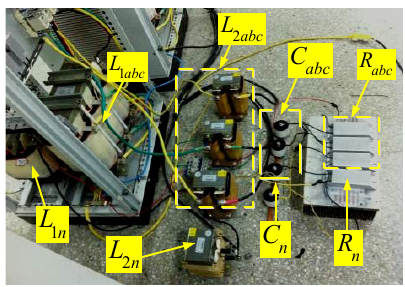
Figure 13. Implemented 4B-LCL circuit.